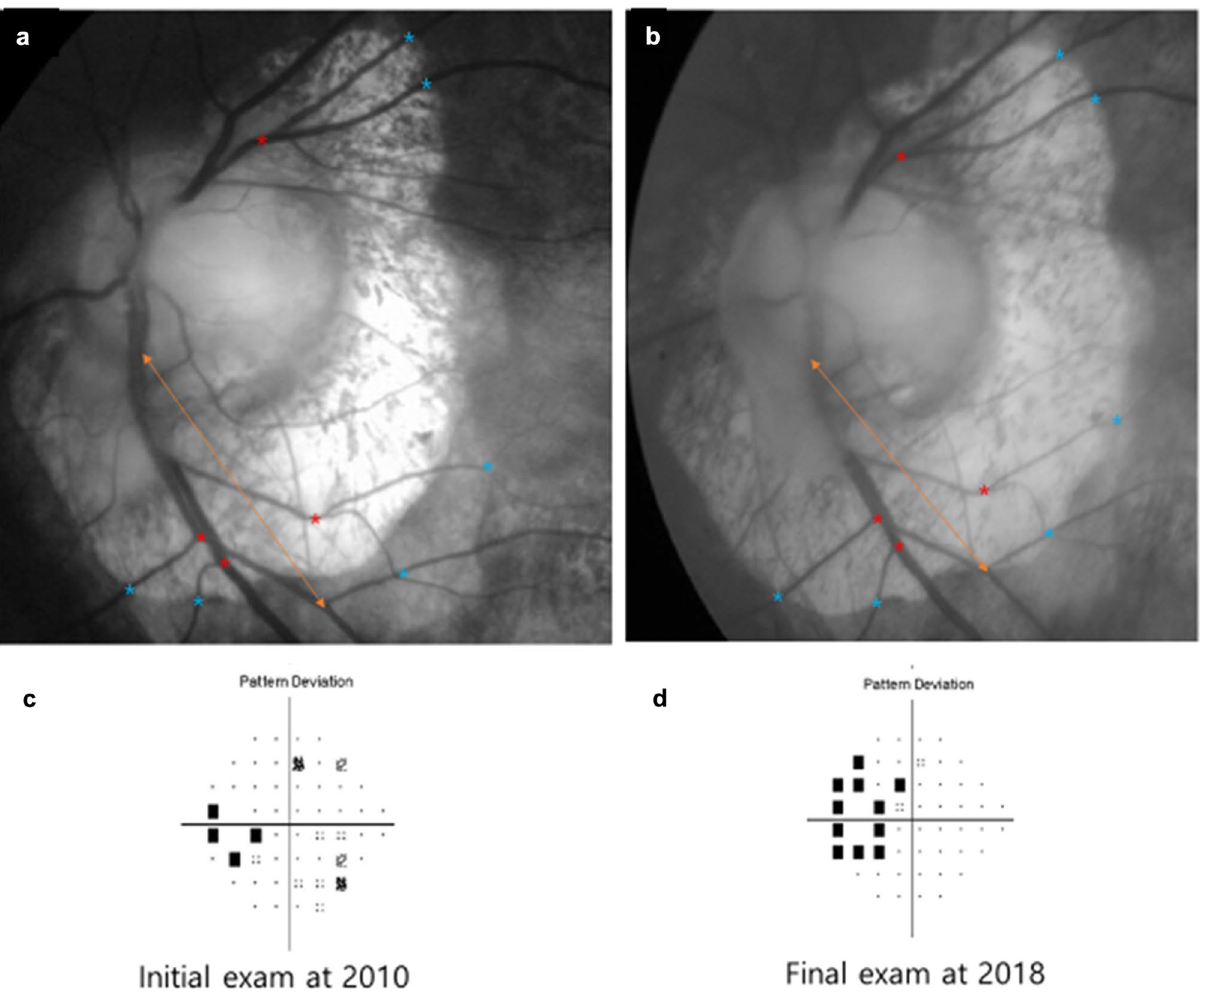
Figure 3. A Representative case with Enlargement of β-Peripapillary Atrophy. 59 years old female patient with axial length 28.41 mm showed that the overall change of β- PPA area over year was 12,115.8 pixel/year ( a and b ) and progression of the temporal visual field defect was observed ( c and d ).